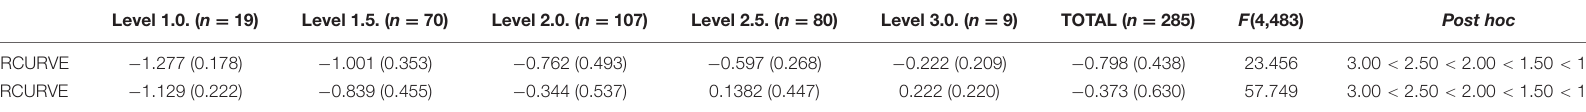
TABLE 11 | Effect of the combined SR-ER levels on the continuous dependent variables SR and ER.